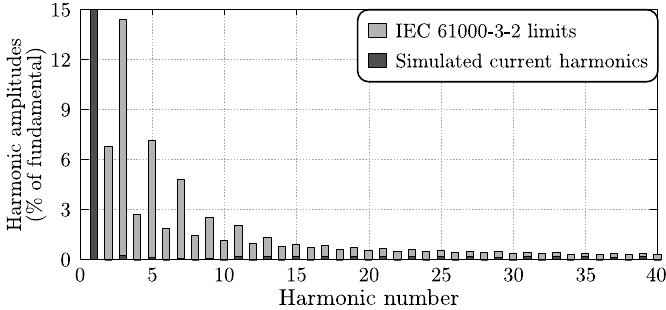
Figure 17. Simulated low-frequency harmonics of the mains current i ac and the IEC61000-3-2